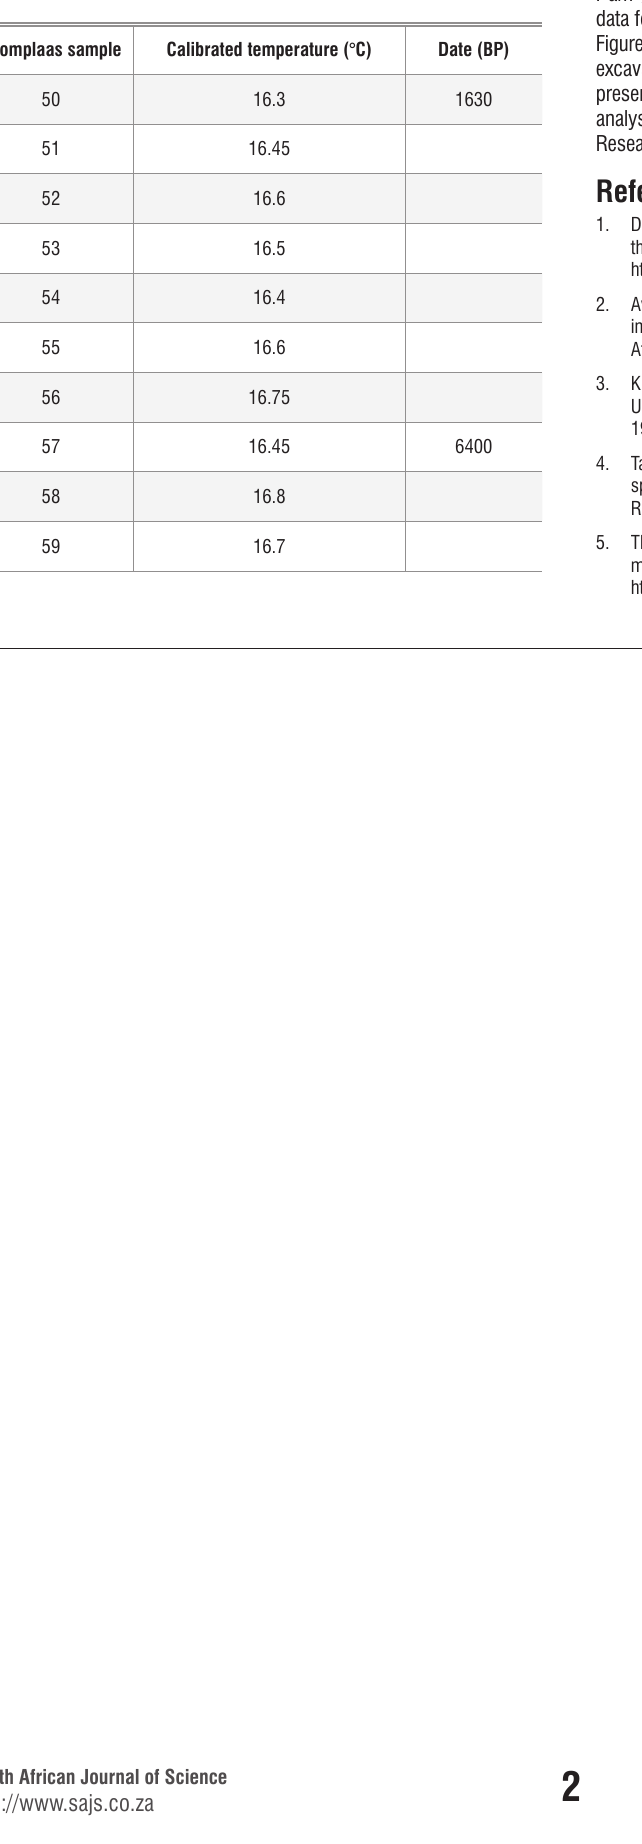
Table 1: Calibrated temperatures for a set of Boomplaas Holocene sam- ples (numbered from 50 to 59), with radiocarbon dates 2